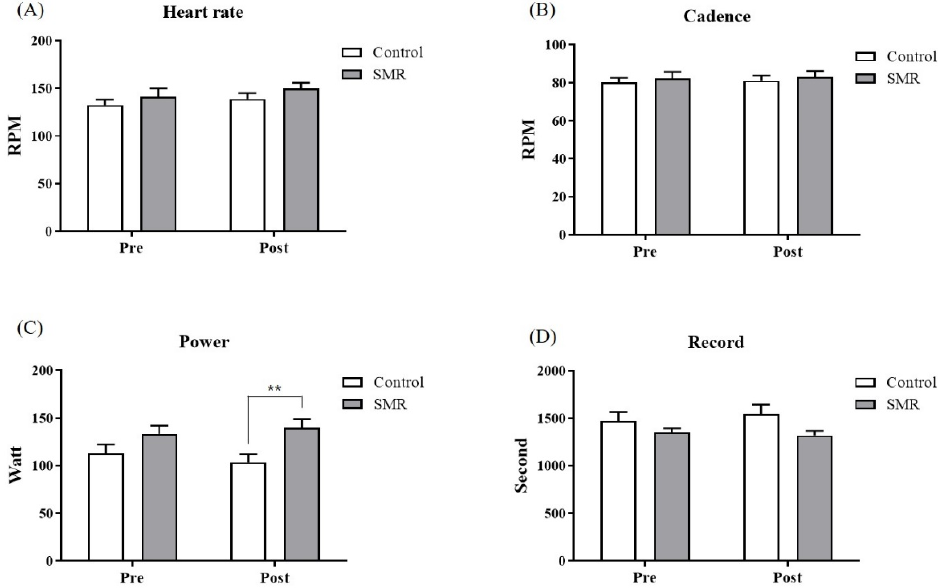
Figure 3. Comparison of exercise performance. (A) Results of the Heart rate; (B) Results of the Cadence; (C) Results of the Power; (D) Results of the Record. ** Superscripts denote statistically significant values (** p < 0.01). Table 4. Power in the longest uphill section.